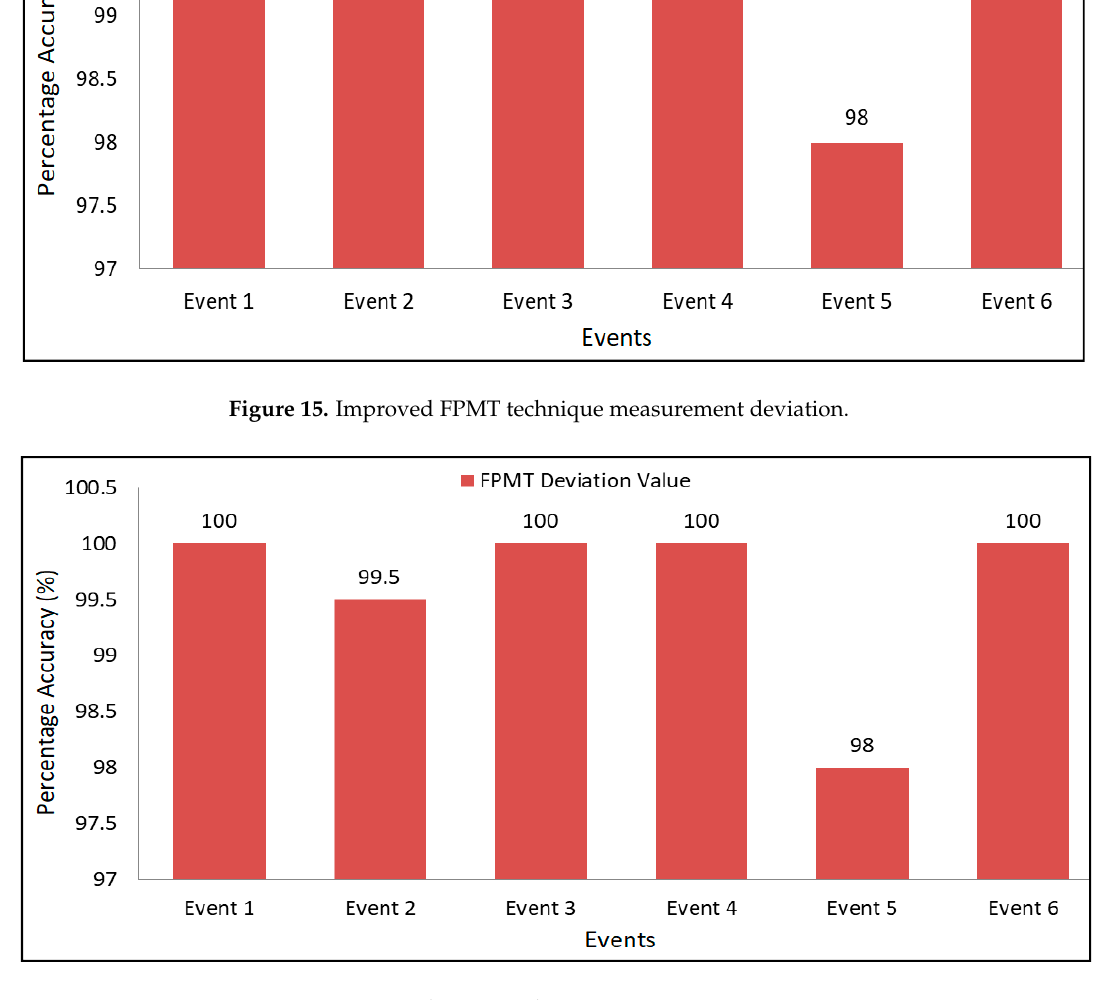
Table 11. Comparison between FPMT techniques integrating with OSC or EDFA